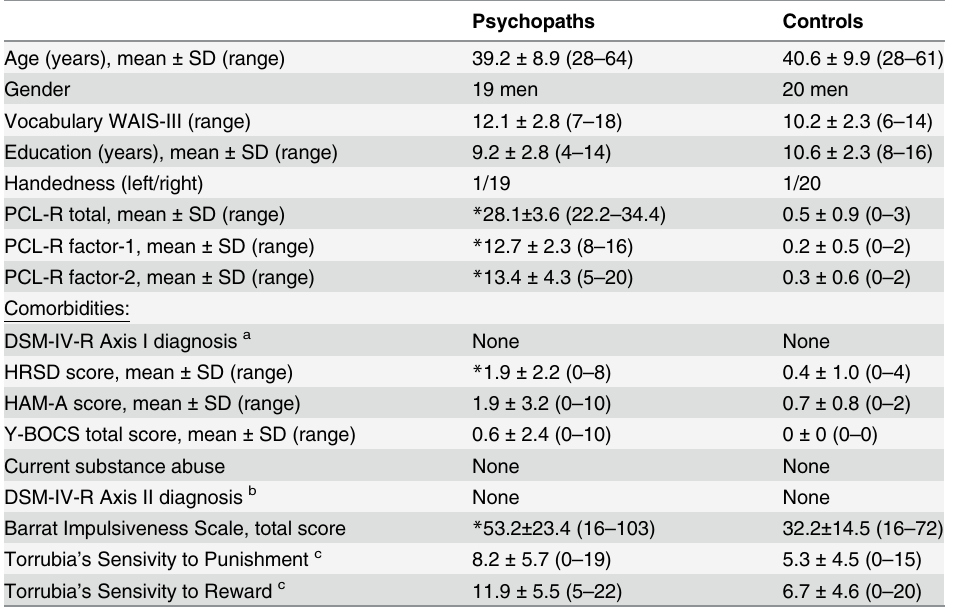
Table 1. Characteristics of study